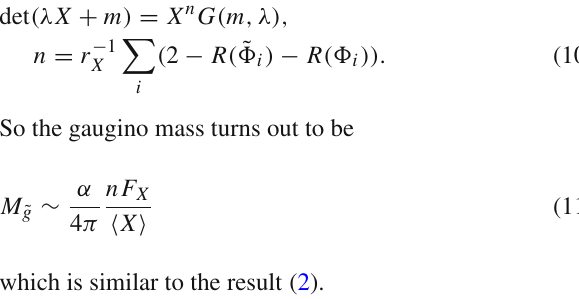
obtain masses from one-loop Feymann diagrams as shown in Fig. 2, which can be calculated by the wave-function renor- malization method [25]. The result is given in